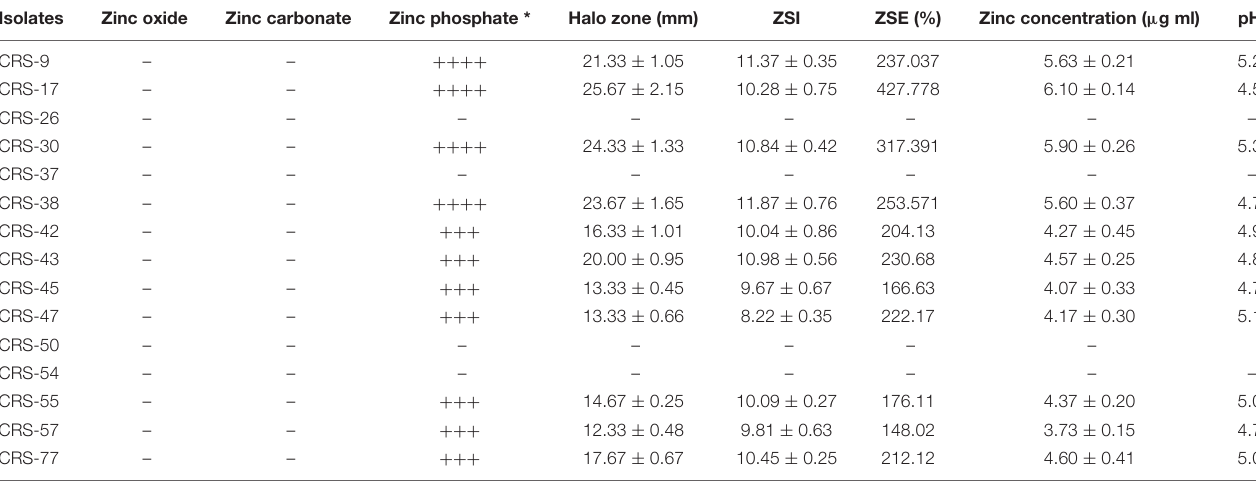
TABLE 1 | Efficacy of rhizobacterial isolates in insoluble solubilize zinc compounds under laboratory conditions. Isolates